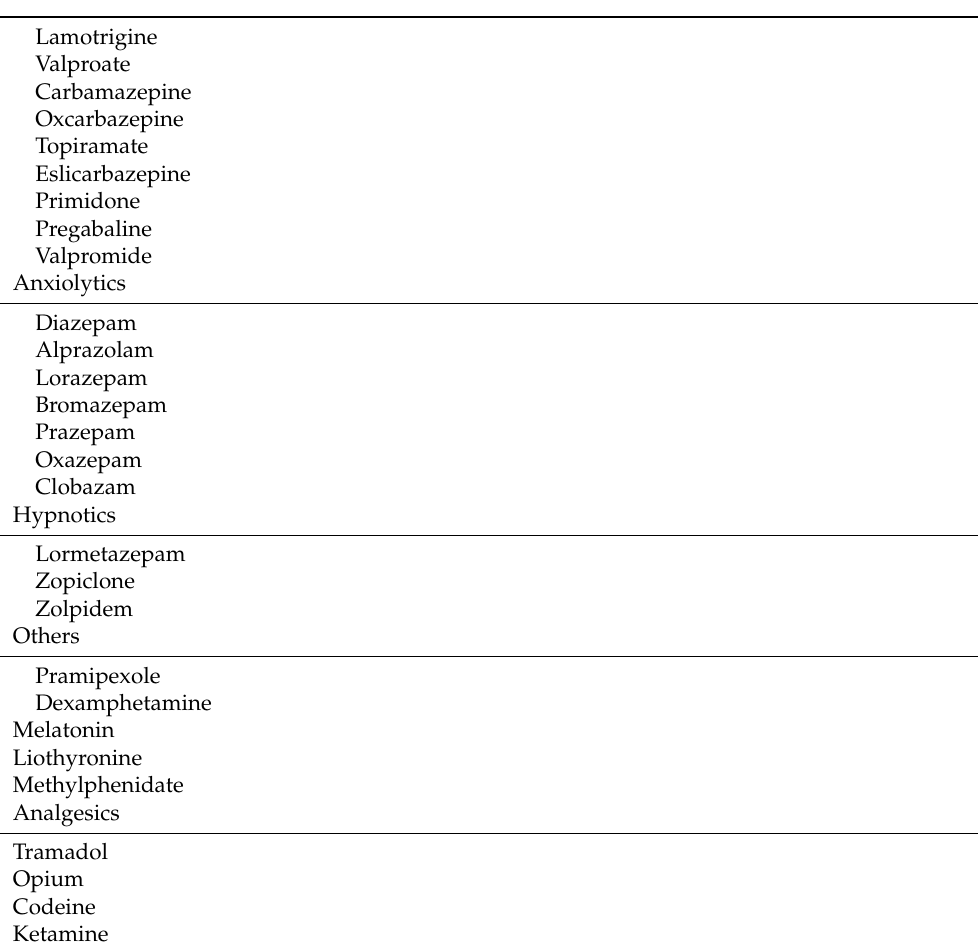
Table A1. Cont. Lamotrigine Valproate Carbamazepine Oxcarbazepine Topiramate Eslicarbazepine